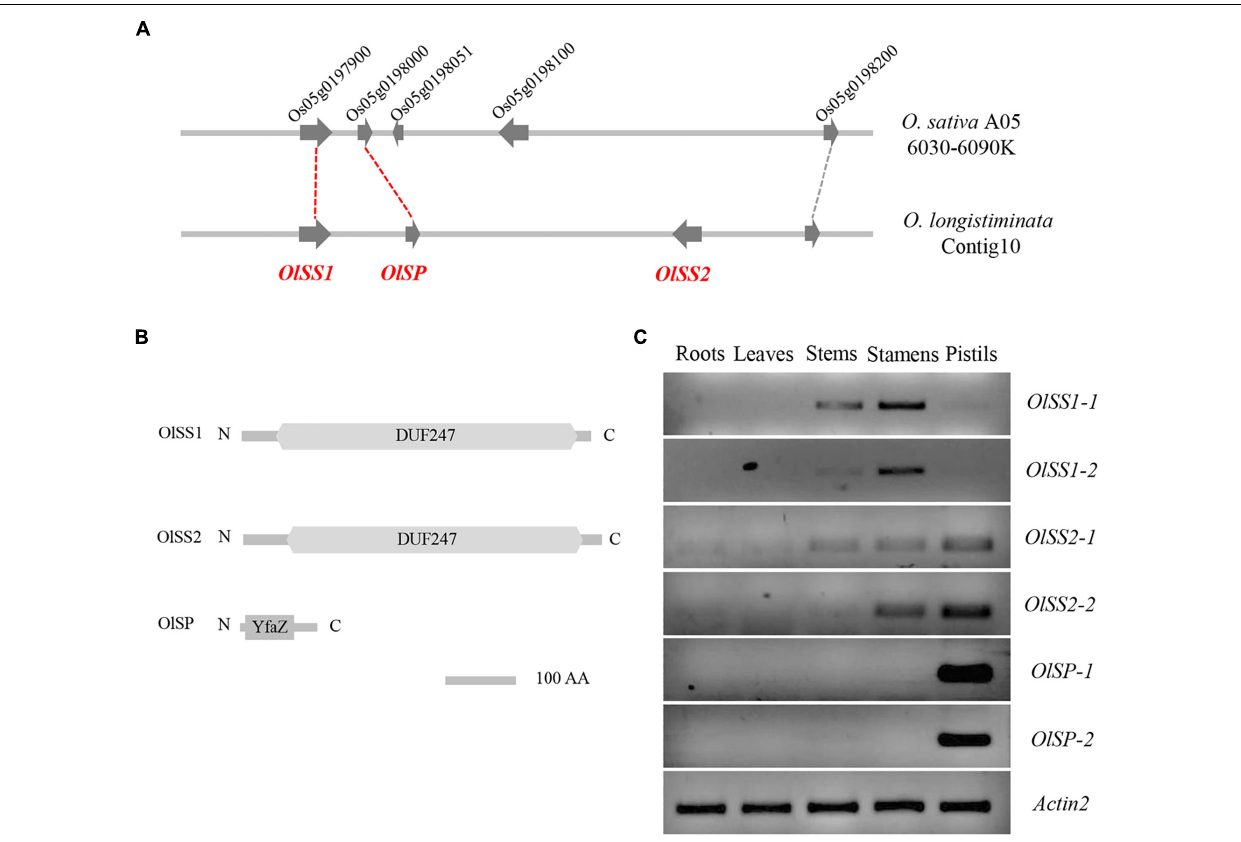
FIGURE 2 | Syntenic and tissue expression of OlSSs and OlSP . (A) Syntenic representation of OlSSs and OlSP in Oryza sativa and Oryza longistaminata . Os05g0197900 , which encodes an unknown DUF247 domain protein in O. sativa , corresponds to OlSS1 , whereas Os05g0198000 and Os05g0198100 correspond to OlSP and OlSS2 respectively. (B) Analysis of OlSS1, OlSS2, and OlSP protein domains. Both OlSS1 and OlSS2 contain a conserved DUF247 domain, whereas OlSP contains an N-terminal YfaZ domain of unknown function. (C) RT-PCR determination of the tissue-specific expression pattern of OlSSs and OlSP in O. longistaminata . OlSS1-1 and OlSS1-2 are mainly expressed in stamens, whereas OlSS2-1 and OlSS2-2 are expressed in both stamens and pistils, and OlSP-1 and OlSP-2 are highly and specifically expressed in pistils. OlSS1 : Self-incompatibility stamen1 from O. longistaminata ; OlSS2 : Self-incompatibility stamen2 from O. longistaminata ; OlSP : Self-Incompatibility Pistil factor from O. longistaminata ; O. sativa A05: Oryza sativa chromosome